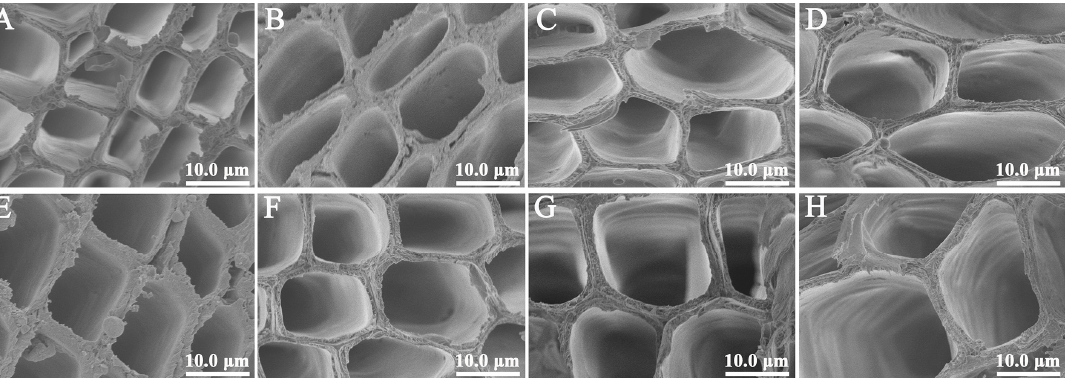
Figure 2. The cell wall morphology of diploid and tetraploid plants at di ff erent developmental stages of P. hopeiensis clone BT1. ( A ) 3-month-old diploid P. hopeiensis . ( B ) 6-month-old diploid P. hopeiensis . ( C ) 9-month-old diploid P. hopeiensis . ( D ) 12-month-old diploid P. hopeiensis . ( E ) 3-month- old tetraploid P. hopeiensis . ( F ) 6-month-old tetraploid P. hopeiensis . ( G ) 9-month-old tetraploid P. hopeiensis . ( H ) 12-month-old tetraploid P. hopeiensis .